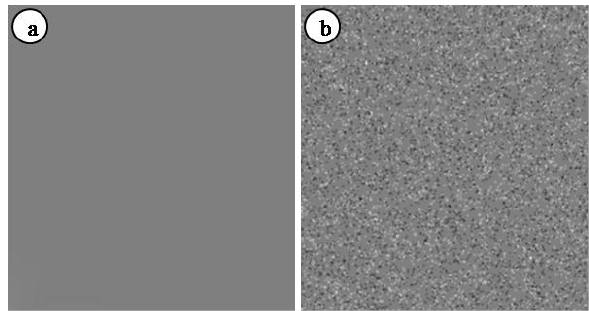
Figure 1. An artificial homogeneous test image; a) reference speckle free image, b) image with a simulated